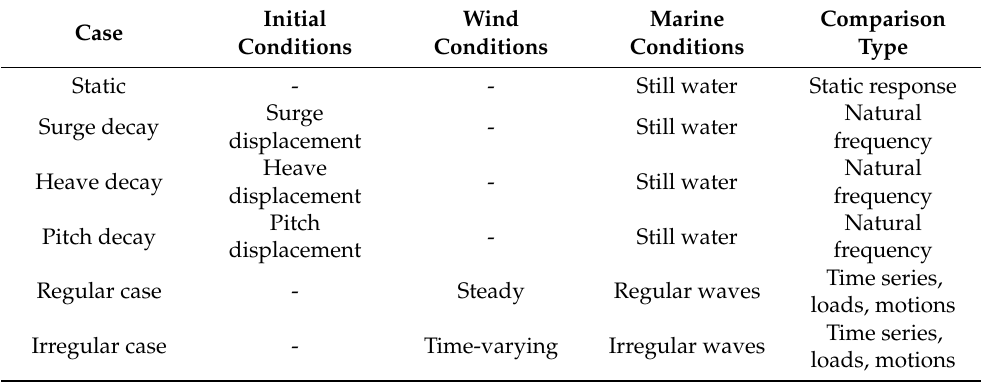
Table 1. Cases used for investigation of modeling approaches and comparison between